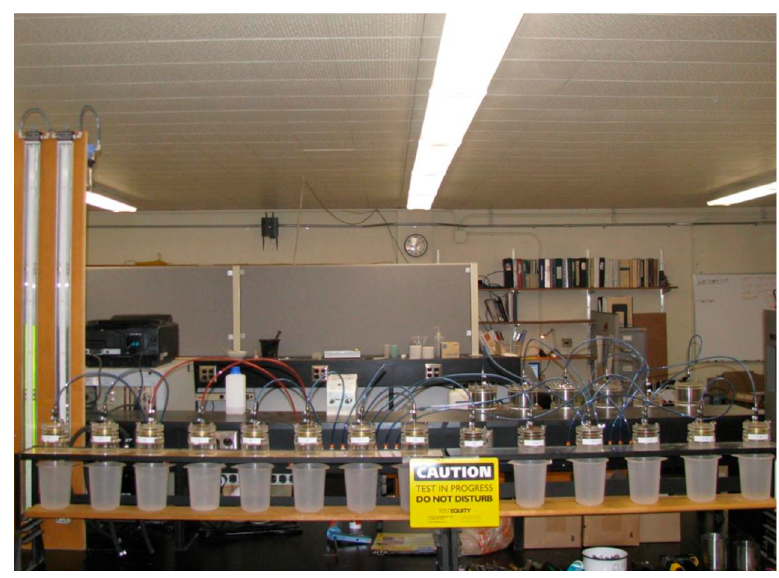
Figure 2. Setup of the Tempe cell experiment.